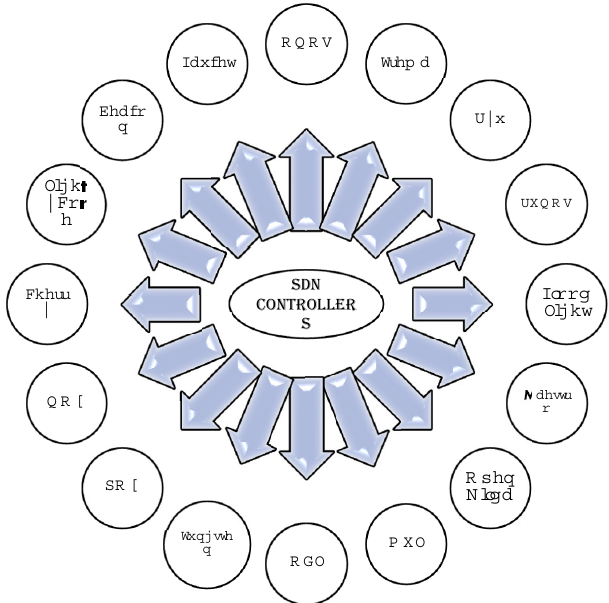
Figure 11. SDN controller.